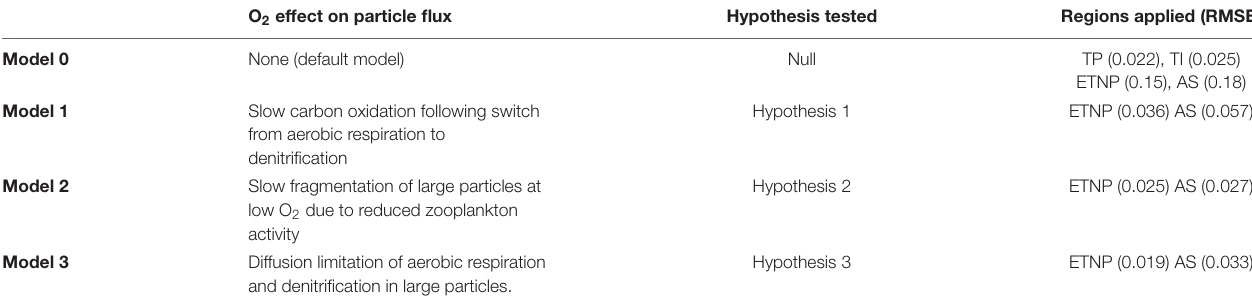
TABLE 1 | Summary of O 2 effects on the particle flux in each model configuration, and the hypothesis that is tested by the